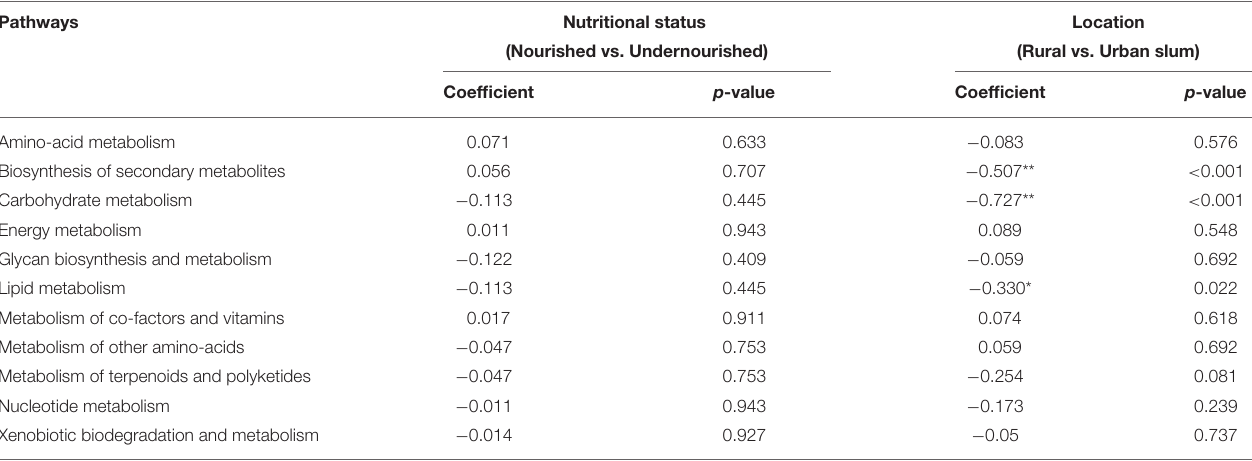
TABLE 2 | Correlation between the pathways identified and the study groups based on the nutritional status (normal vs. undernourished) or location (rural vs. urban slum). Pathways Nutritional status Location (Nourished vs. Undernourished) (Rural vs. Urban slum) Coefficient p -value Coefficient p